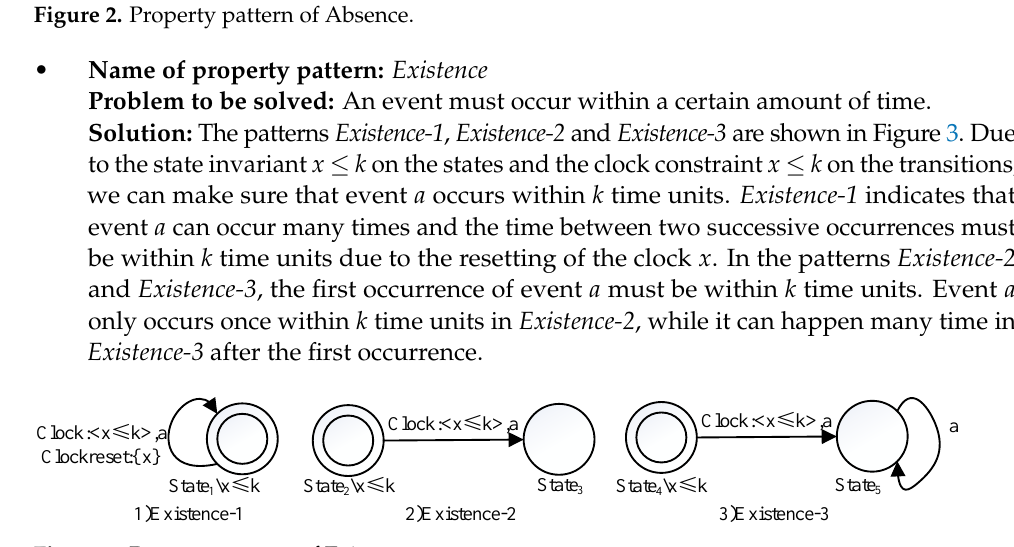
Figure 3. Property pattern of